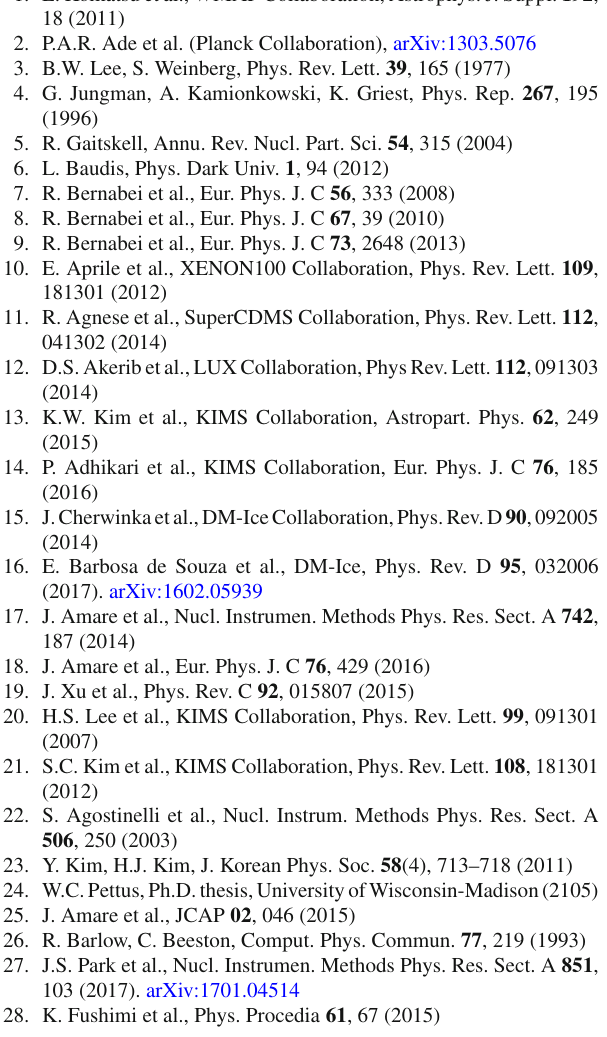
the external backgrounds , which amounted to 0.59dru. In the low energy region below 0.5 keV the data is suppressed by the requirement for low energy noise rejection and there is shown less number of events in the